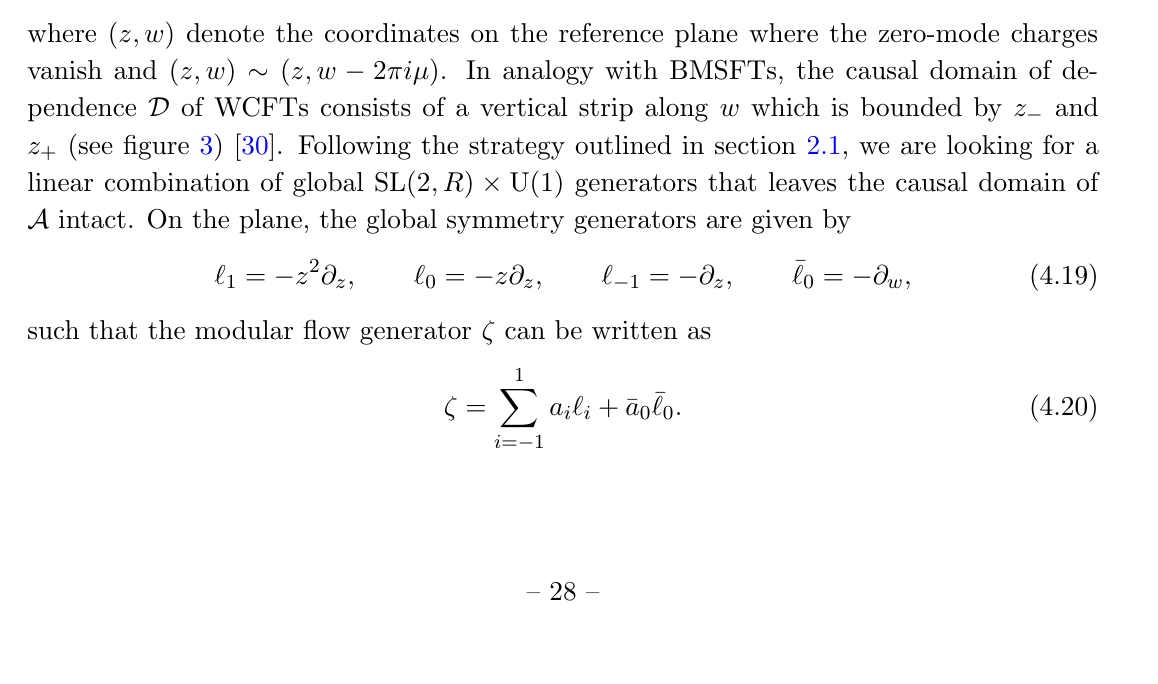
Figure 3 . The modular (cid:13)ow of a WCFT on the plane with (cid:22) between ( z ) and ( z ) and its causal domain ; w + ; w + (cid:0) (cid:0) in is shown in red while the modular (cid:13)ow in the complement is shown in D